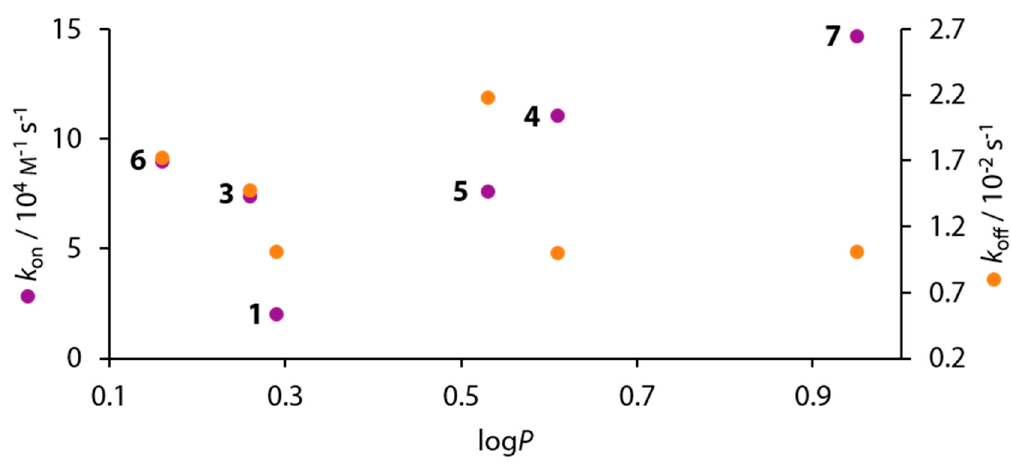
Figure 13. Plot of k on (purple, left ordinate) and k off (orange, right ordinate) against log P shows, that hydrophobicity is not a determining factor for the binding kinetics of fluorinated BSAs.